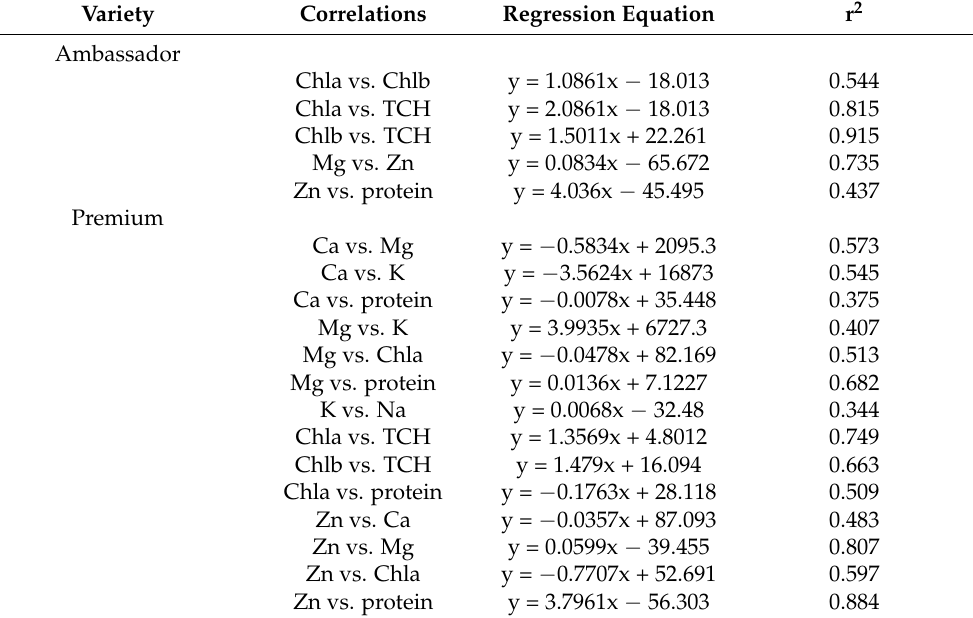
Table 4. Results of regression analysis between minerals, protein and chlorophylls investigated for seed of two pea varieties (Ambassador and